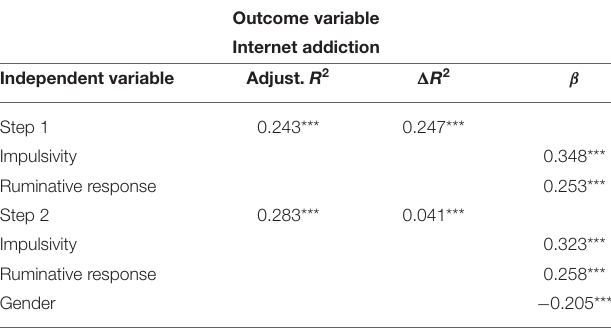
TABLE 5 | Results of hierarchical linear regression